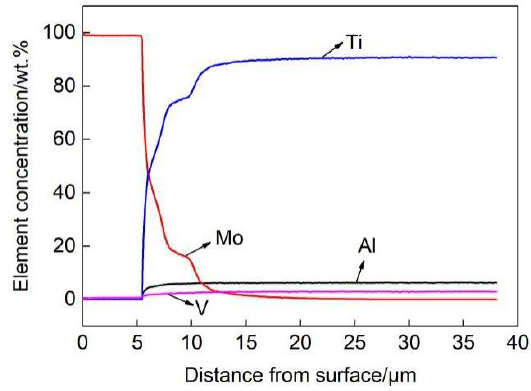
Figure 5. Element concentration profile of the Mo surface-modified TC4.